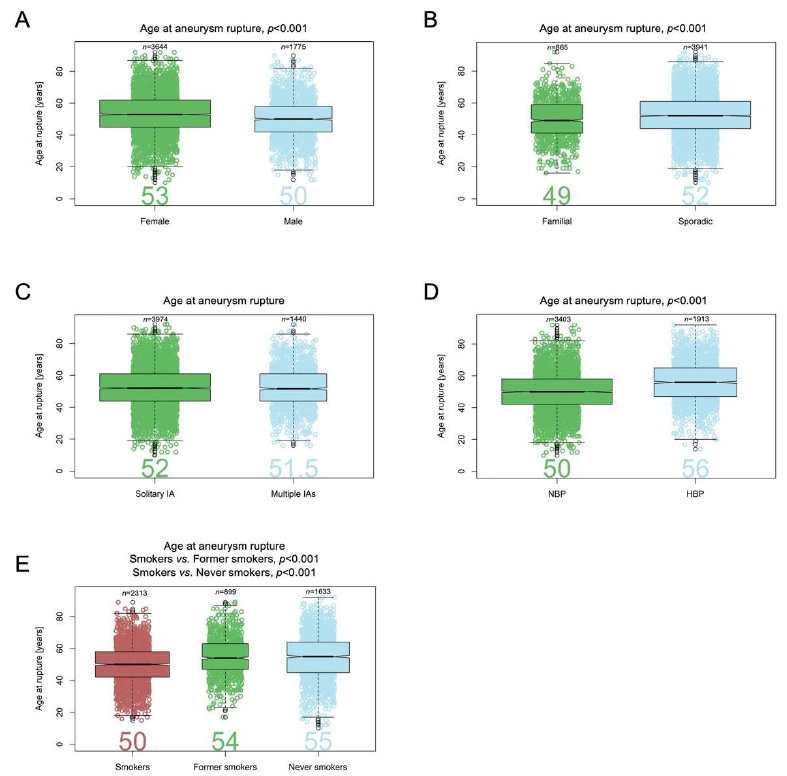
Figure 4. Patient’s age at time of rupture and risk factors for rupture. Patient’s age at IA rupture by sex ( A ), family history of IA ( B ), IA multiplicity ( C ), blood pressure ( D ), and smoking status ( E ).